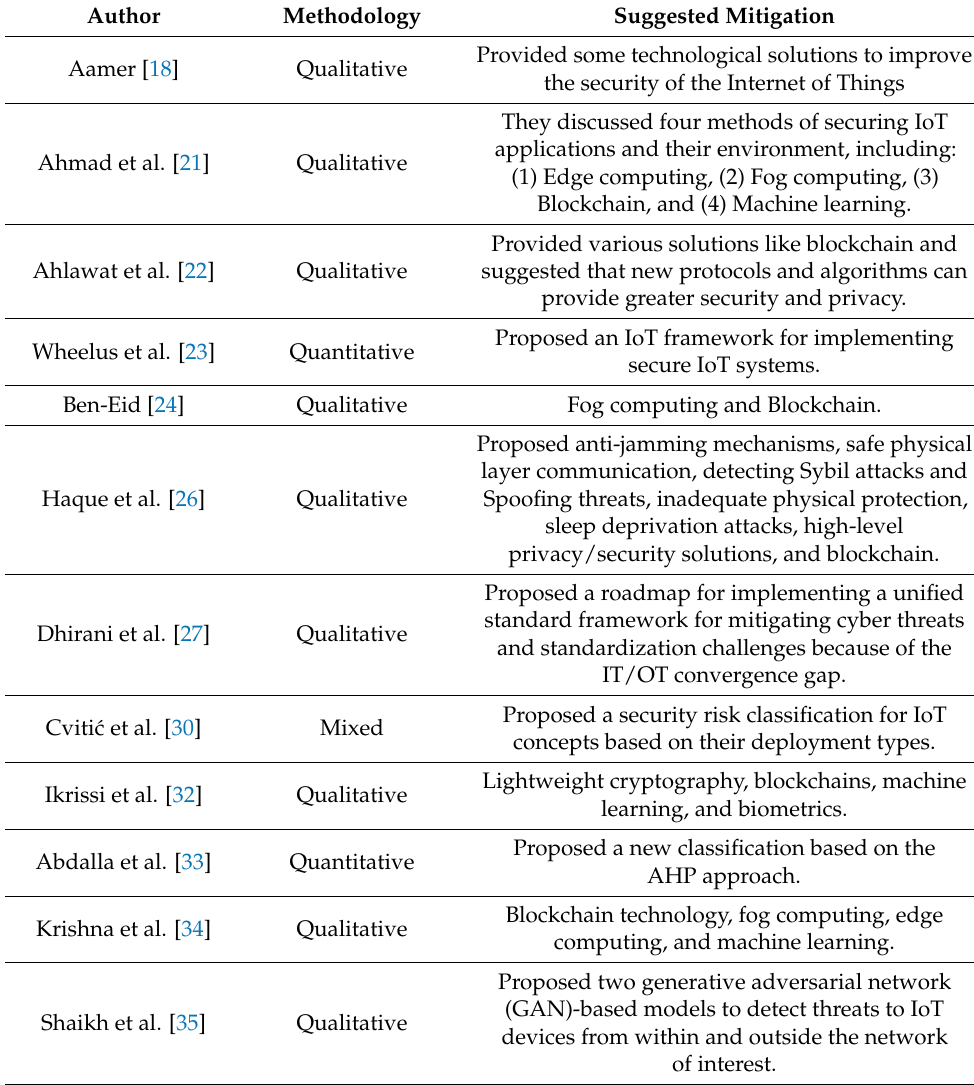
Table 7. Summary of the suggested mitigation for IoT